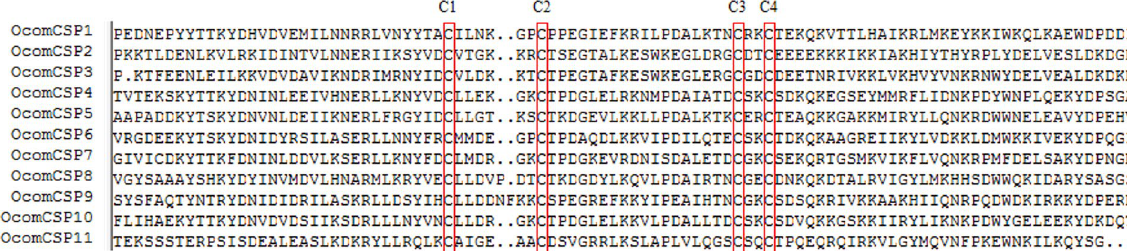
Figure 3. Sequences alignment of candidate OcomCSPs amino acid sequences. The conserved cysteine residues were marked with red box.